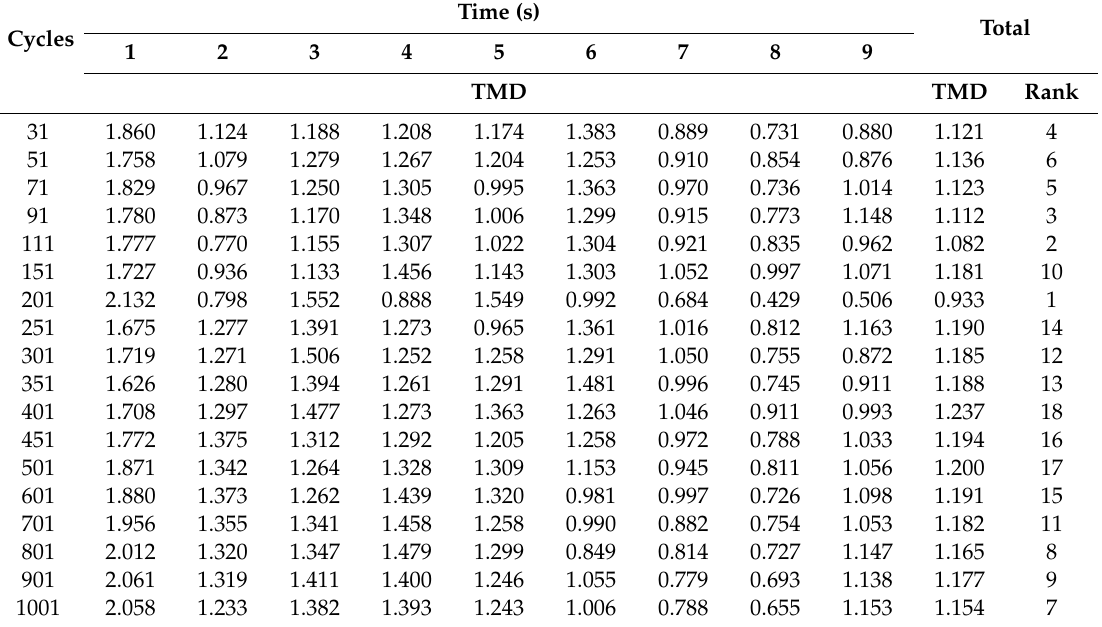
Table 6. Results of time-based Mahalanobis distance (TMD) analysis between T Thc and T Rec for 18 candidate